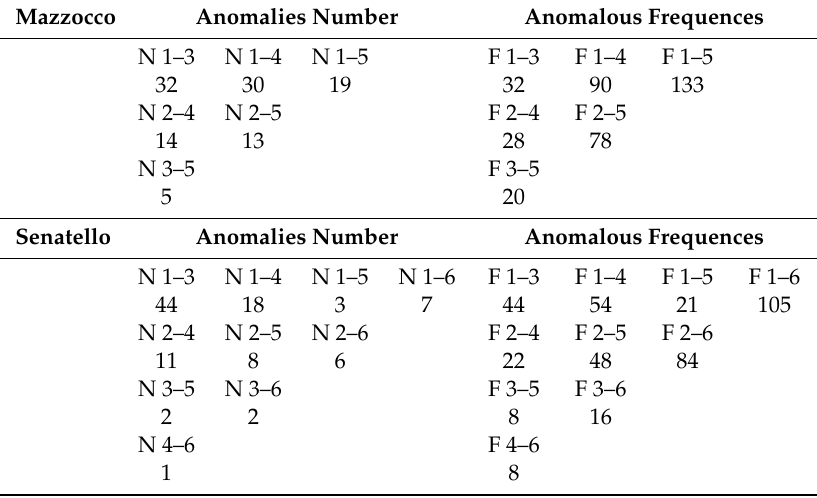
Table 3. Anomalies number and anomalous frequencies of Mazzocco and Senatello river basins.